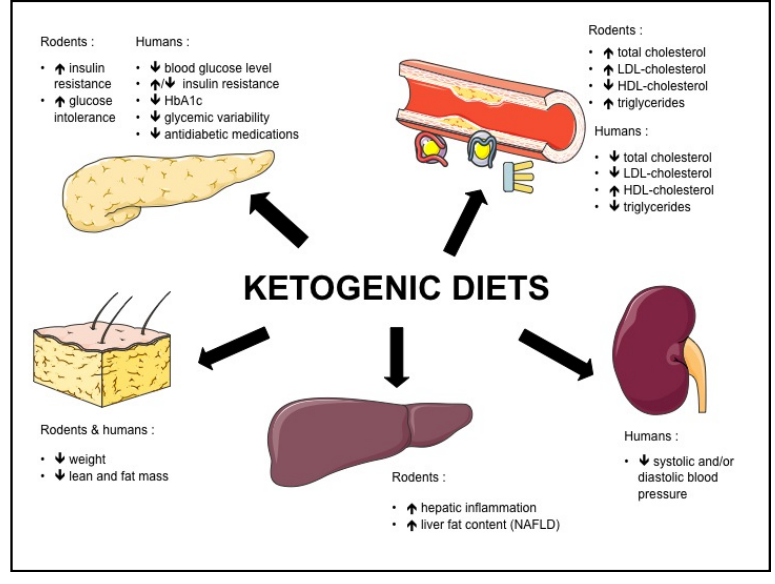
Figure 1. Effects of ketogenic diets in rodents and humans.